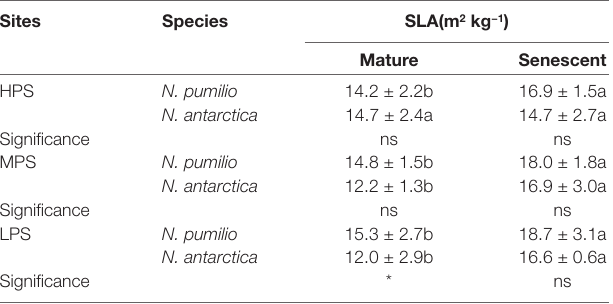
TaBlE 2 | Specific leaf area (SLA) values ± standard deviation of N. pumilio and N. antarctica mature and senescent leaves collected from three contrasting sites (HQS, MQS and